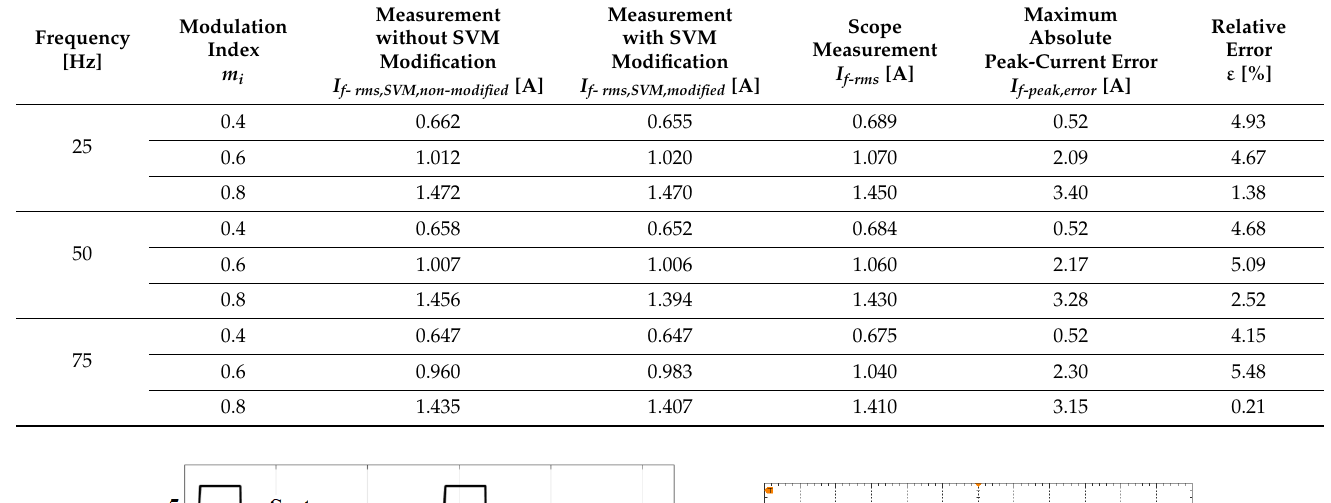
Table 11. Performance index for measurement results.